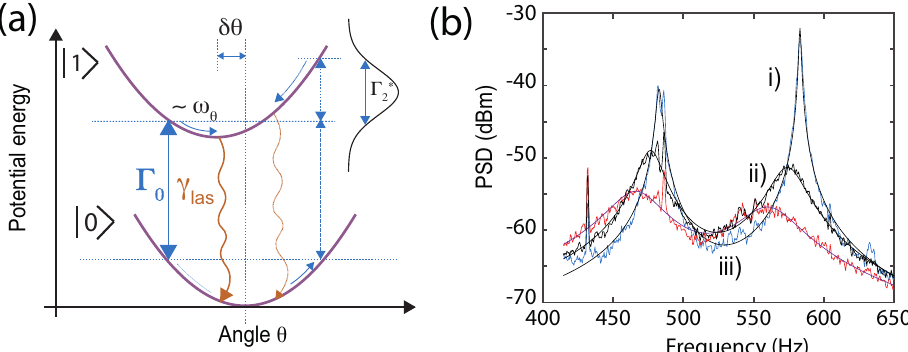
Figure 8. ( a ) Spin-cooling mechanism described in the adiabatic limit. The two angular potential wells in the spin states | 0 (cid:105) and | 1 (cid:105) are offset from one another by δθ due to the spin-torque. They are coupled via the laser and microwave tone at the rates γ las and Γ , respectively, see text for explanations. Here the microwave is tuned to the red, enabling cooling. ( b ) PSD of two librational modes when the microwave is tuned to the blue (trace i) to resonance (trace ii) and to the red (trace iii) of the spin-resonance, respectively. Adapted from